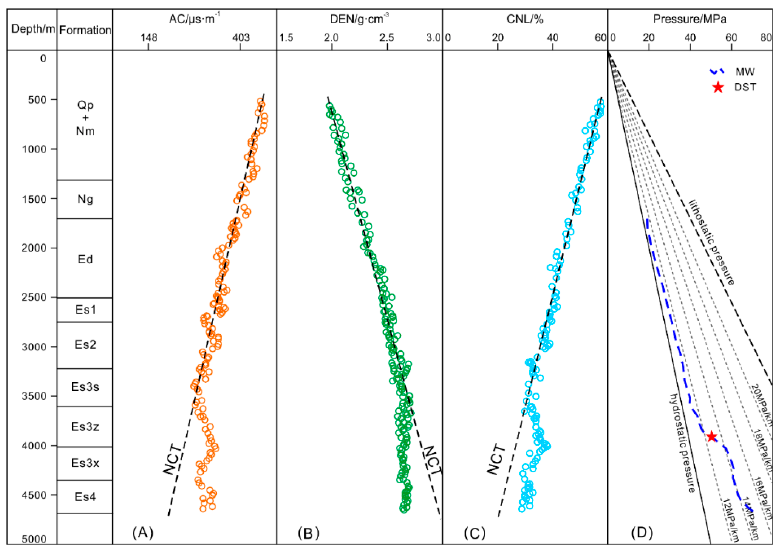
Figure 3. Comprehensive mudstone compaction curves of well X99, including ( A ) acoustic, ( B ) density, ( C ) neutron logs, ( D ) mud weights (MW), and DST data. The well location is shown in Figure 1C.